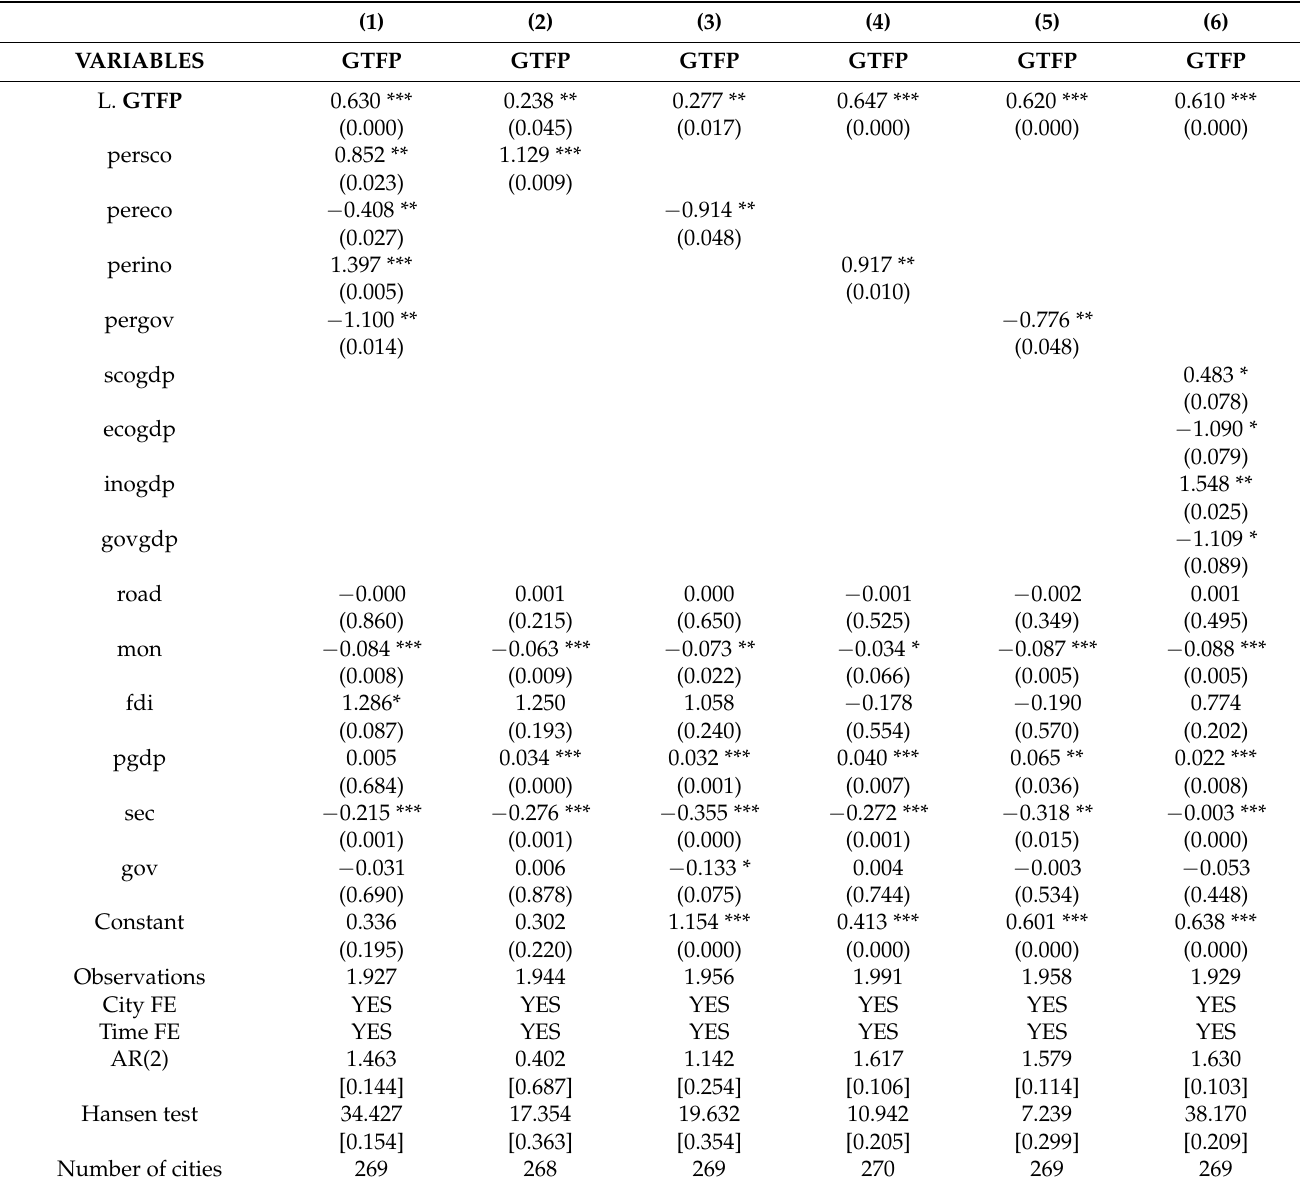
Table 7. Estimation results of the impact of public expenditure composition on